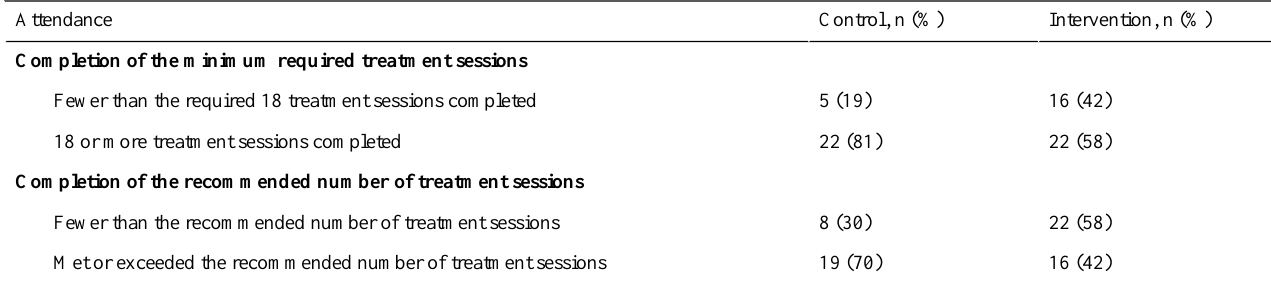
Completion of the minimum required treatment